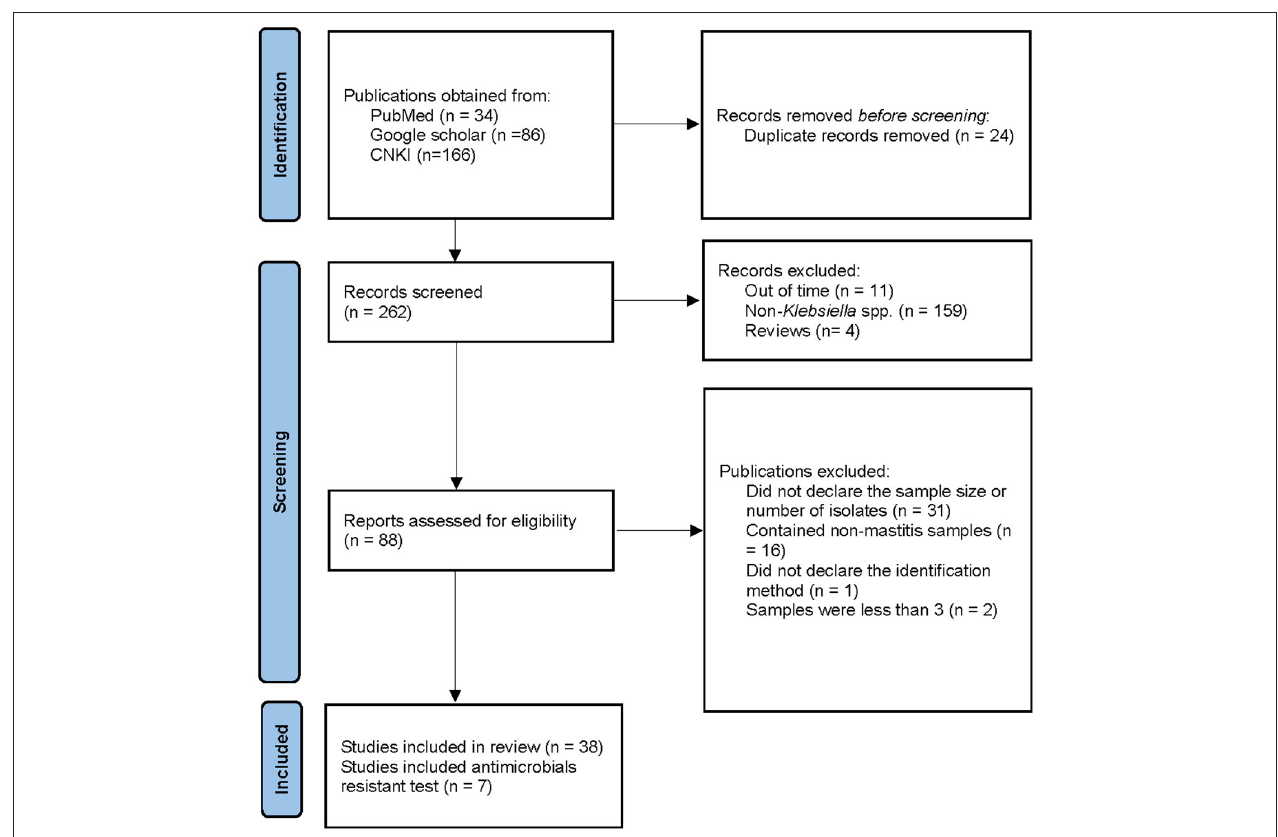
FIGURE 1 | Search and selection criteria for literatures. CNKI means Chinese National Knowledge